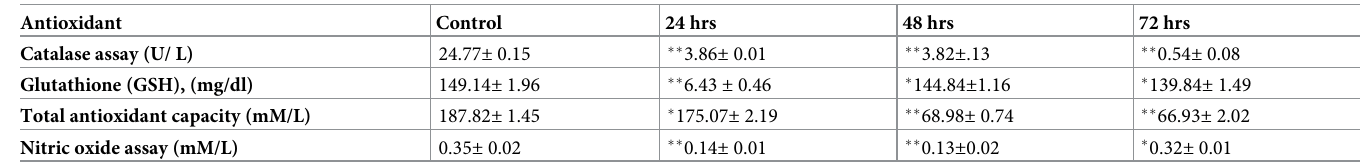
Table 2. Antioxidant effects of Biomphalaria alexandrina snails after exposure to LC 25 silver nanoparticles (Ag-NPs) for 24, 48 and 72